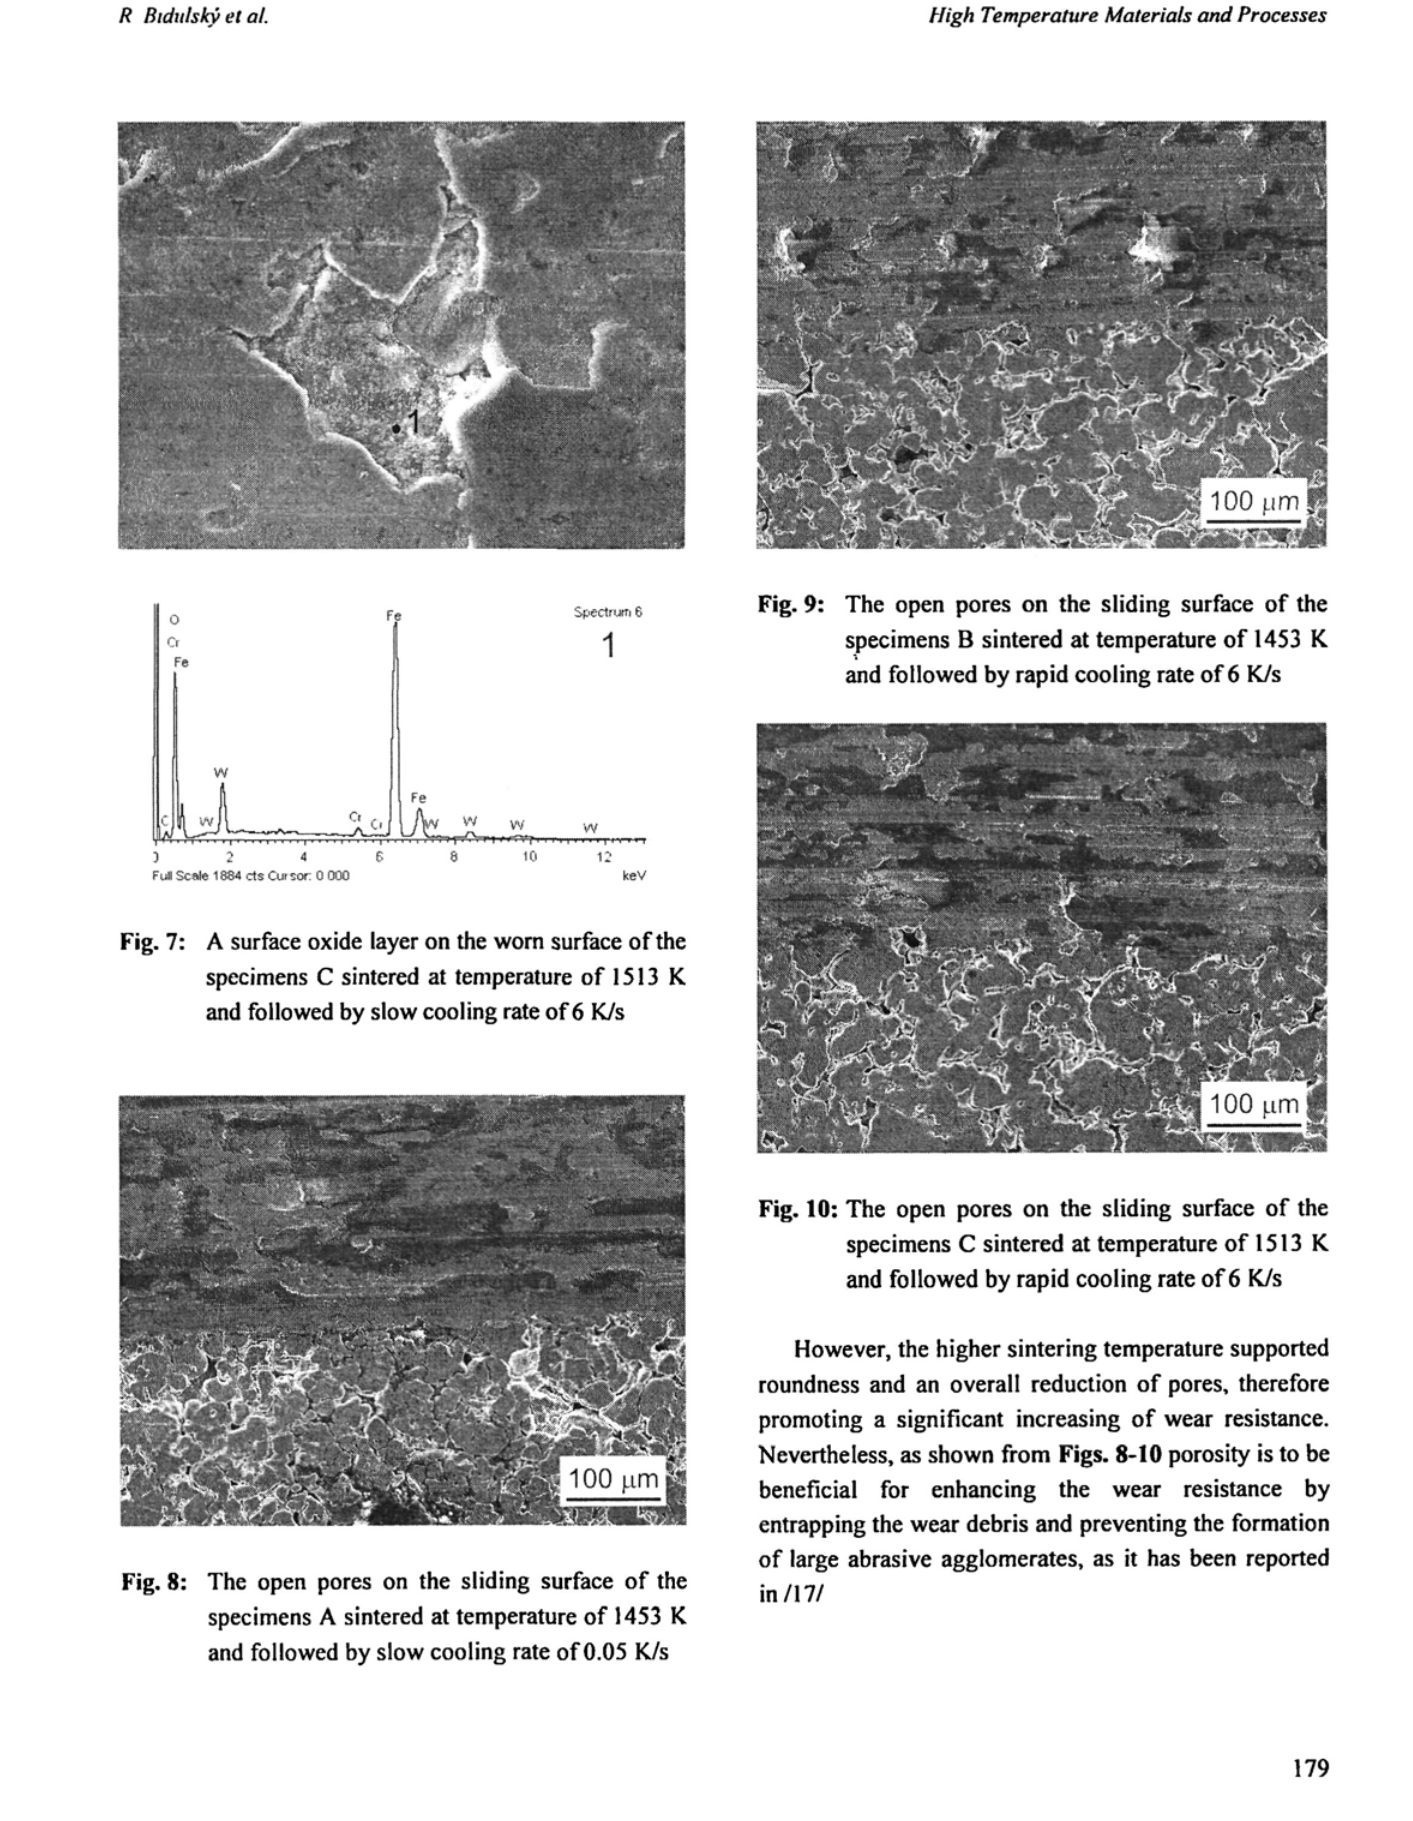
Fig. 8: The open pores on the sliding surface of the specimens A sintered at temperature of 1453 K and followed by slow cooling rate of 0.05 K/s